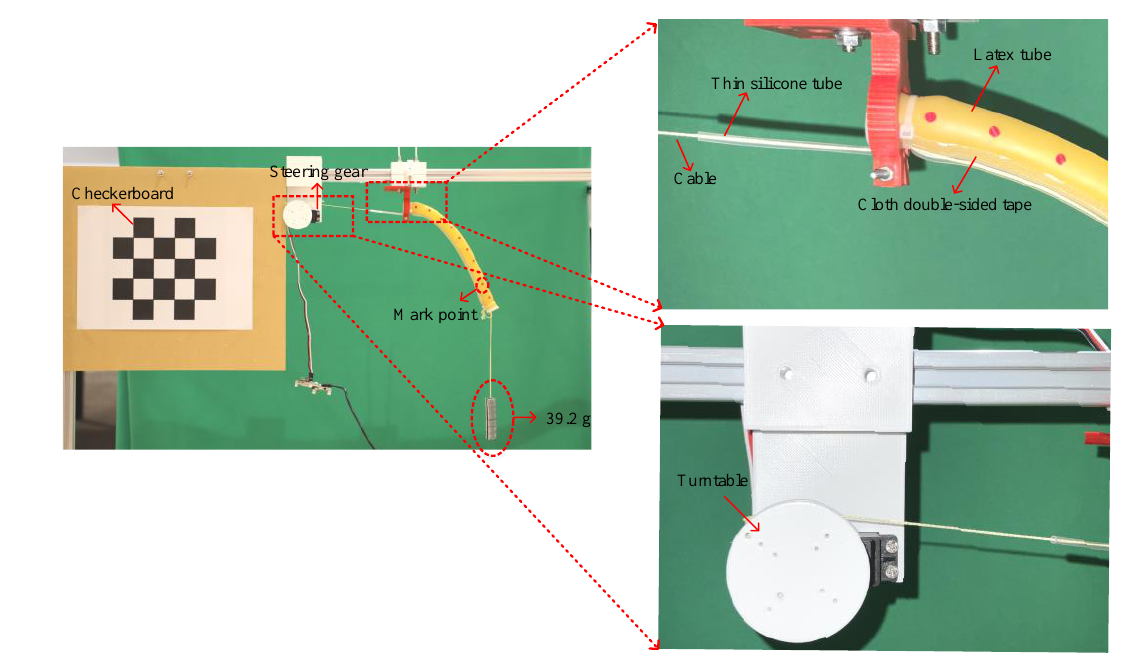
Figure 5. ( a ) Diagram of cable drive soft arm; ( b ) Turntable made by the 3D printer used to fix the cable on the steering gear.